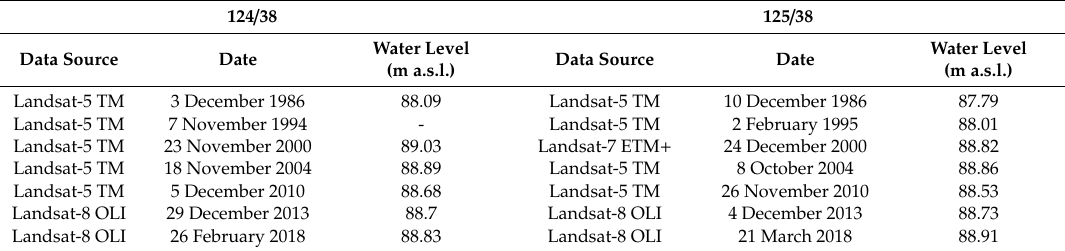
Table 2. The 30 m resolution remote sensing data and corresponding water levels of Huangjiagang hydrologic station in the study area.